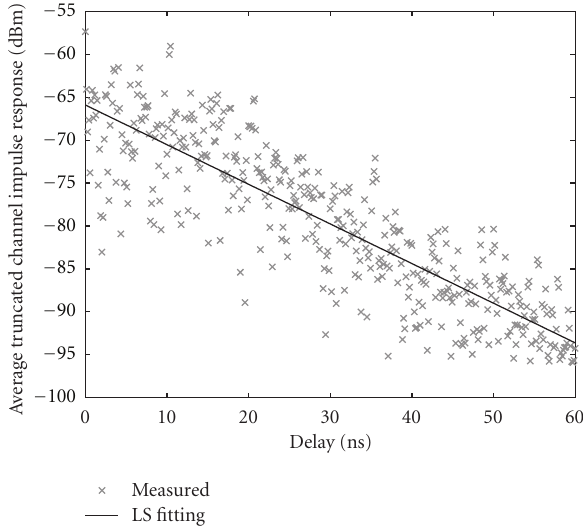
Figure 5: Average channel impulse responses for the UWB band for Rx17 (LOS) and the least square linear fitting curve in dB